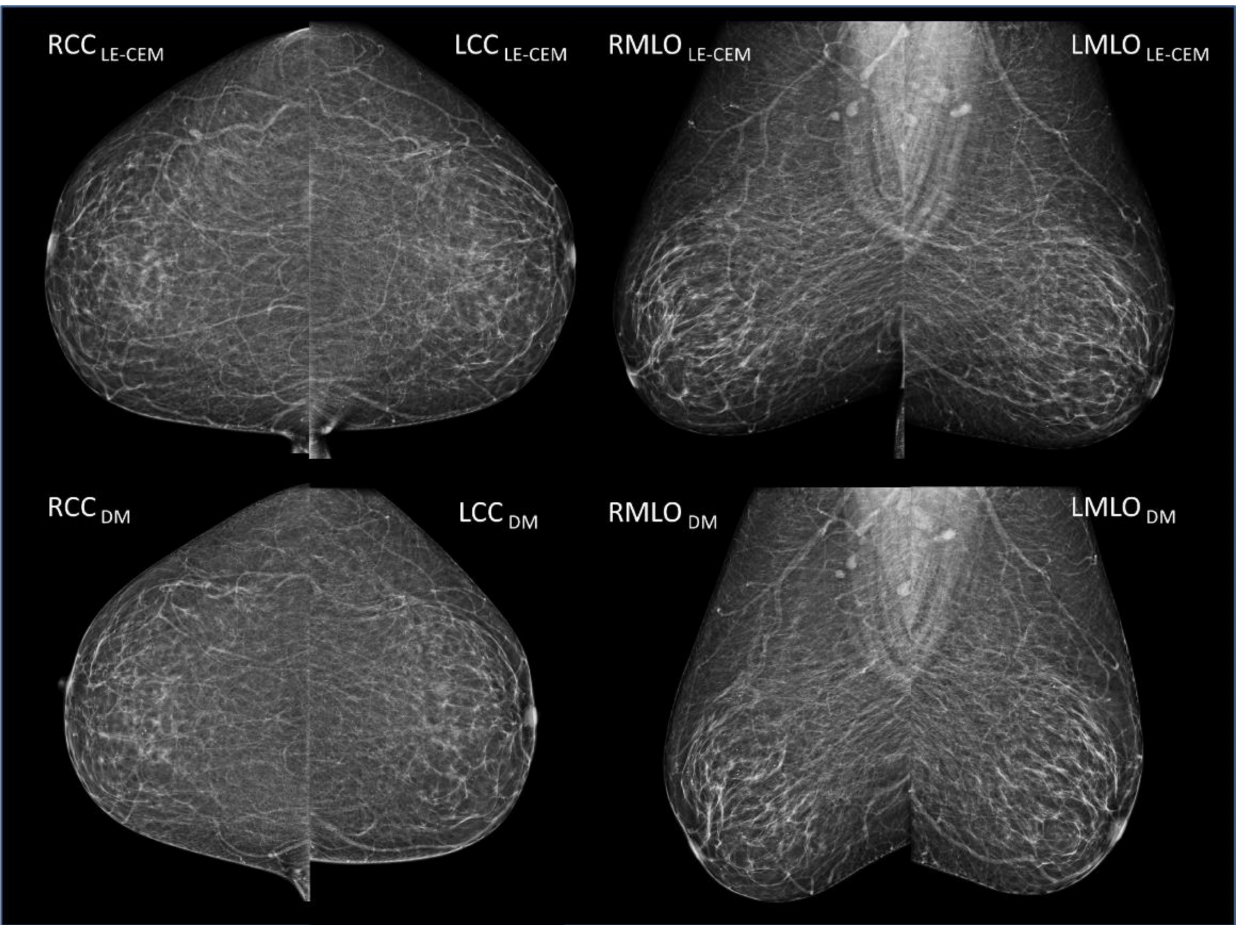
Figure 2. (Upper row) LE-CEM images of a woman with large fatty breasts. VBD: 1.9%; breast volume: 2634 cm 3 ; volume of glandular tissue: 51 cm 3 ; breast thickness: 85 mm; nipple-to-posterior-edge distance: 174 mm. (Lower row) DM images acquired 12 months before the CEM exam. VBD: 2.7%: breast volume: 2058 cm 3 ; volume of glandular tissue: 54 cm 3 ; breast thickness: 76 mm; nipple-to-posterior-edge distance: 155 mm. Despite the visible difference in breast positioning, the large reduction in breast volume due to worse positioning in the DM exam did not produce a significant variation in breast density, due to the breasts being predominantly